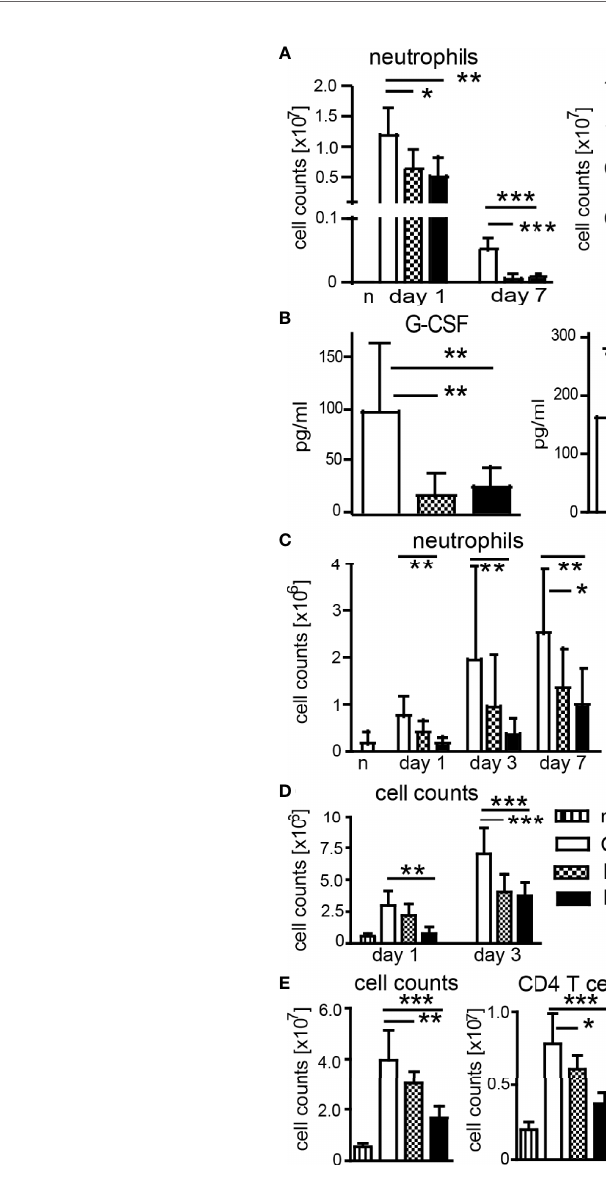
FIGURE 2 | Mincle- and MyD88-dependent pathways contribute to local monocyte and neutrophil recruitment and increased lymph node cellularity. (A) Cell numbers at d1 and d7 and (B) chemokines in peritonal lavage 7 days post-DDA/TDB i.p. Pooled data from fi ve independent experiments with a total of n=6 – 10 mice per group and time point. (C) Cellular in fl ux after NBD-DDA/TDB s.c. footpad immunization. Pooled data from seven independent experiments with a total of n=6 – 9 mice per group/time point. n, naive C57BL/6 control. (D) Numbers of cells isolated from popliteal lymph nodes 1 and 3 days p.i., s.c. footpad immunization with NBD-DDA/TDB. Pooled data from two independent experiments with a total of fi ve to six mice per group/time point. (E) Cell numbers in pooled popliteal and inguinal lymph nodes 7 days p.i. All data presented as mean+SD. Signi fi cance tested by one-way ANOVA for each time point and Dunnett ’ s post-test with immunized C57BL/6 as control group. *p < 0.05, **p < 0.01, ***p < 0.001. For gating, see Supplementary Figure S1